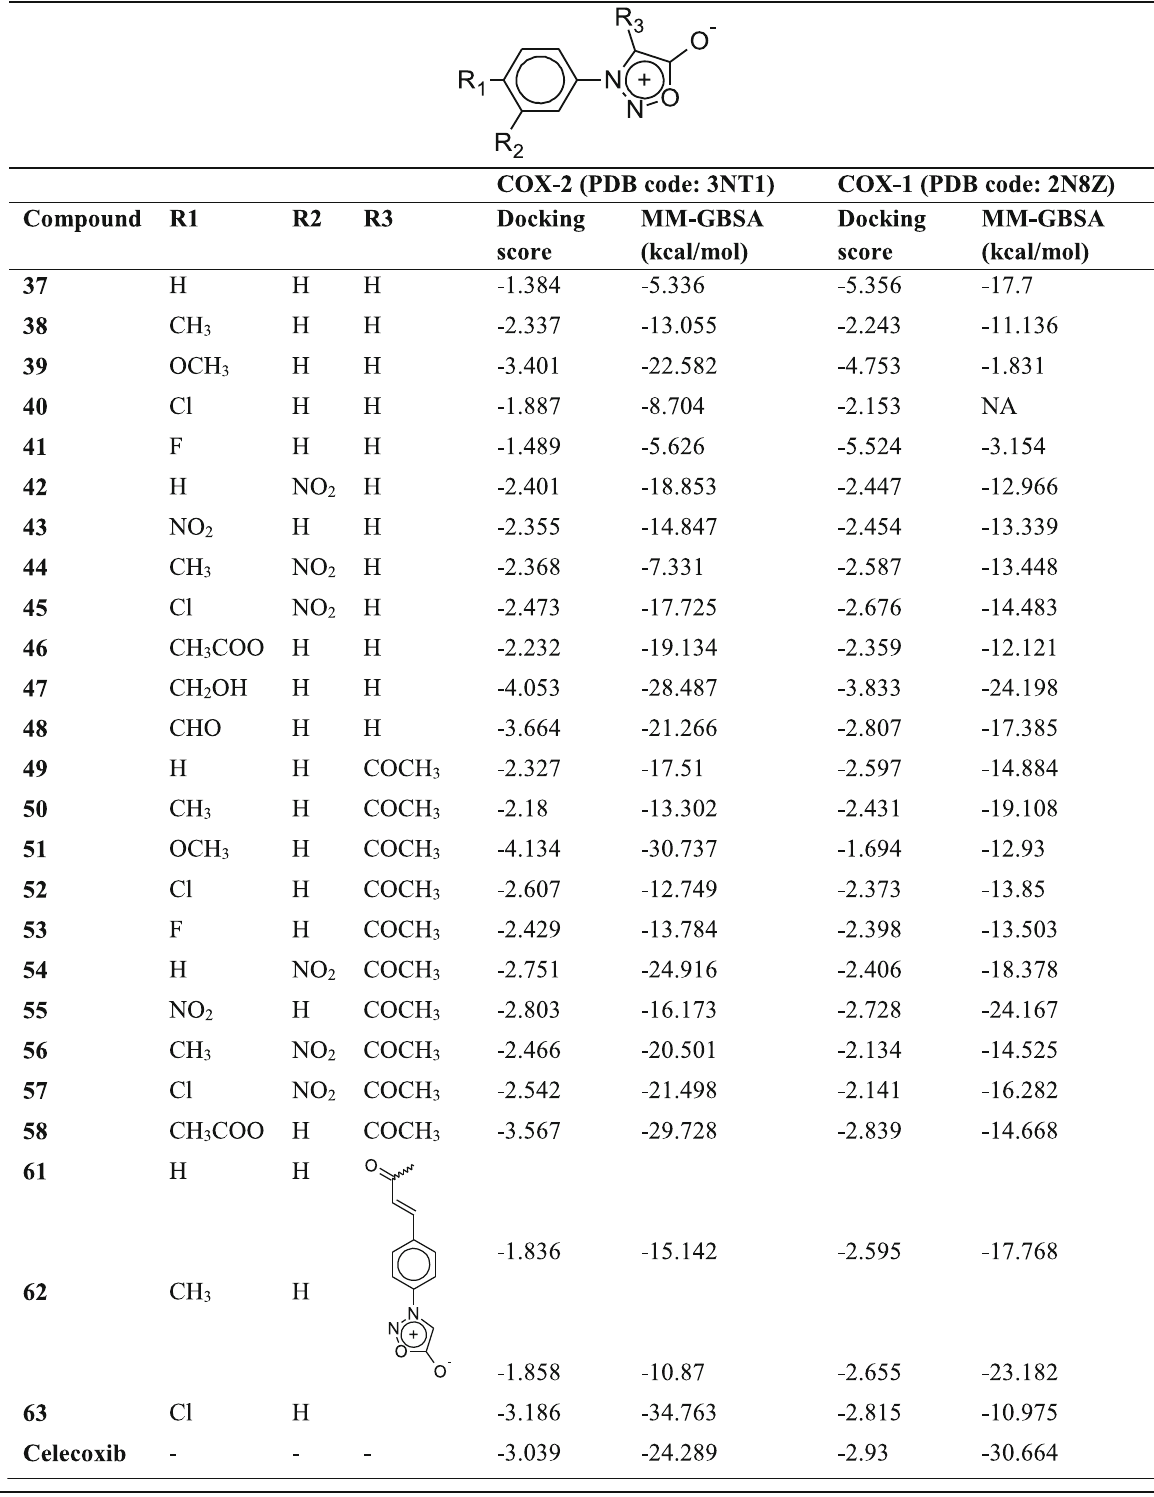
Table 2 Extra precision (XP) binding scores and molecular mechanics based on generalised born/surface area (MM-GBSA) for docking poses of 37 – 58 and 61 – 63 into cyclooxygenase